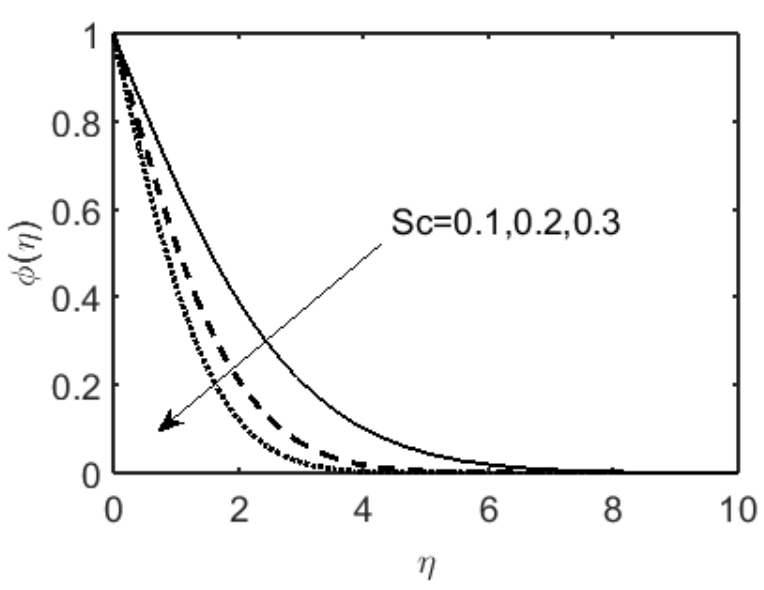
Figure 9. Impact of Sc on concentration.